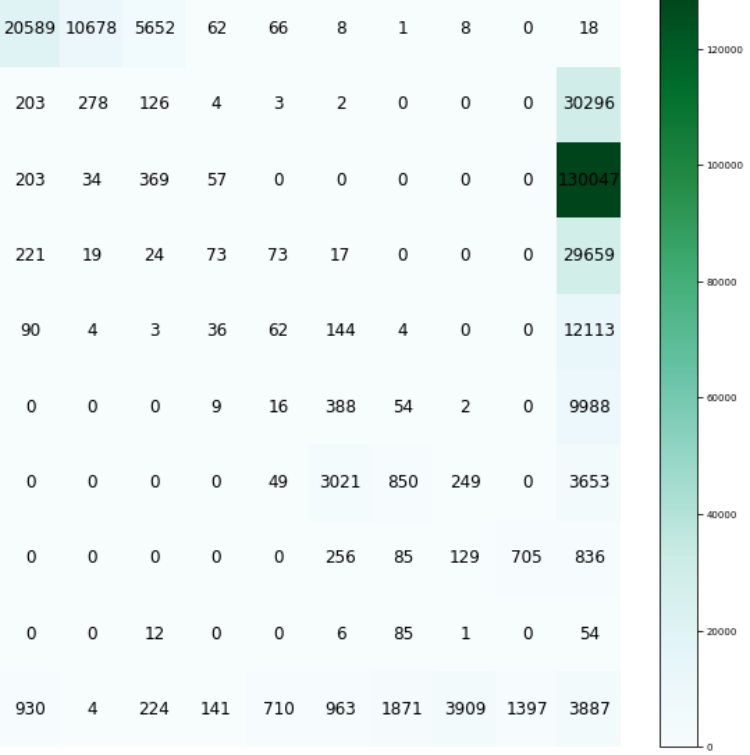
Figure 5. Heat map of distances to individual clusters.